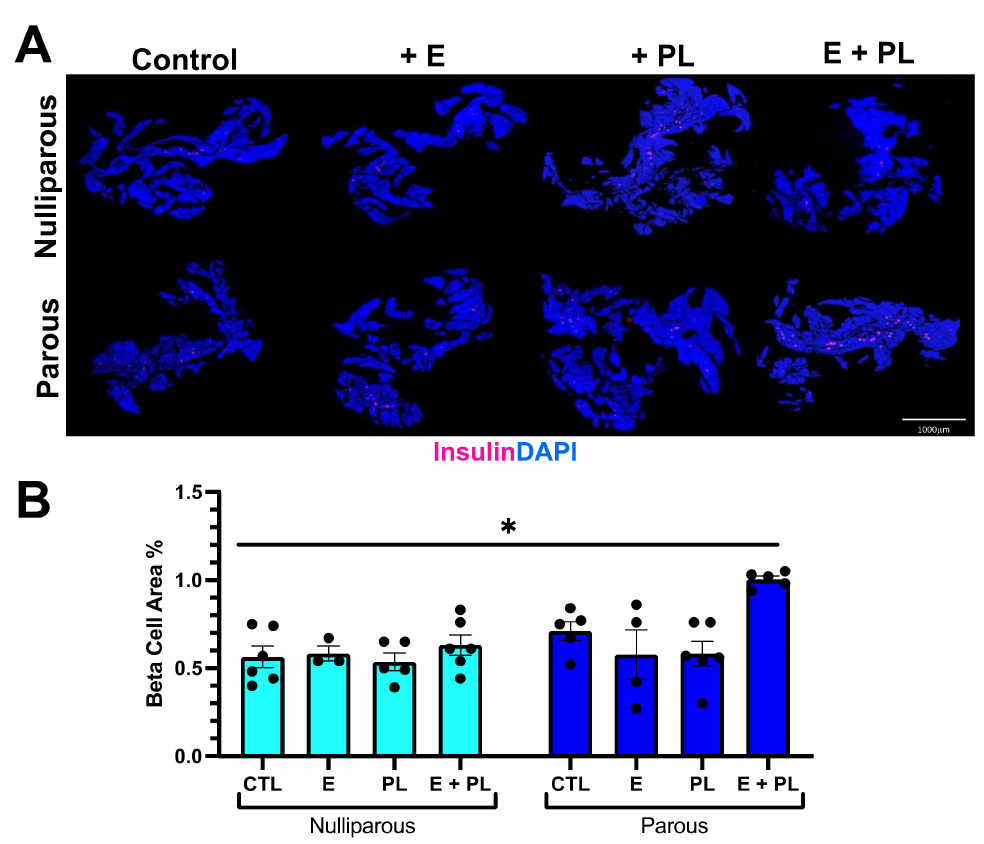
Figure 1. Pseudopregnancy promotes beta cell mass expansion in parous mice. ( A ) Representative pancreata stained with insulin (magenta) and DAPI (blue) from each treatment group, 5 × tile images stitched using ImageJ. ( B ) Quantification of beta cell mass (insulin/DAPI ratio); n = 3–6, * p = 0.02 using Kruskal-Wallis non-parametric